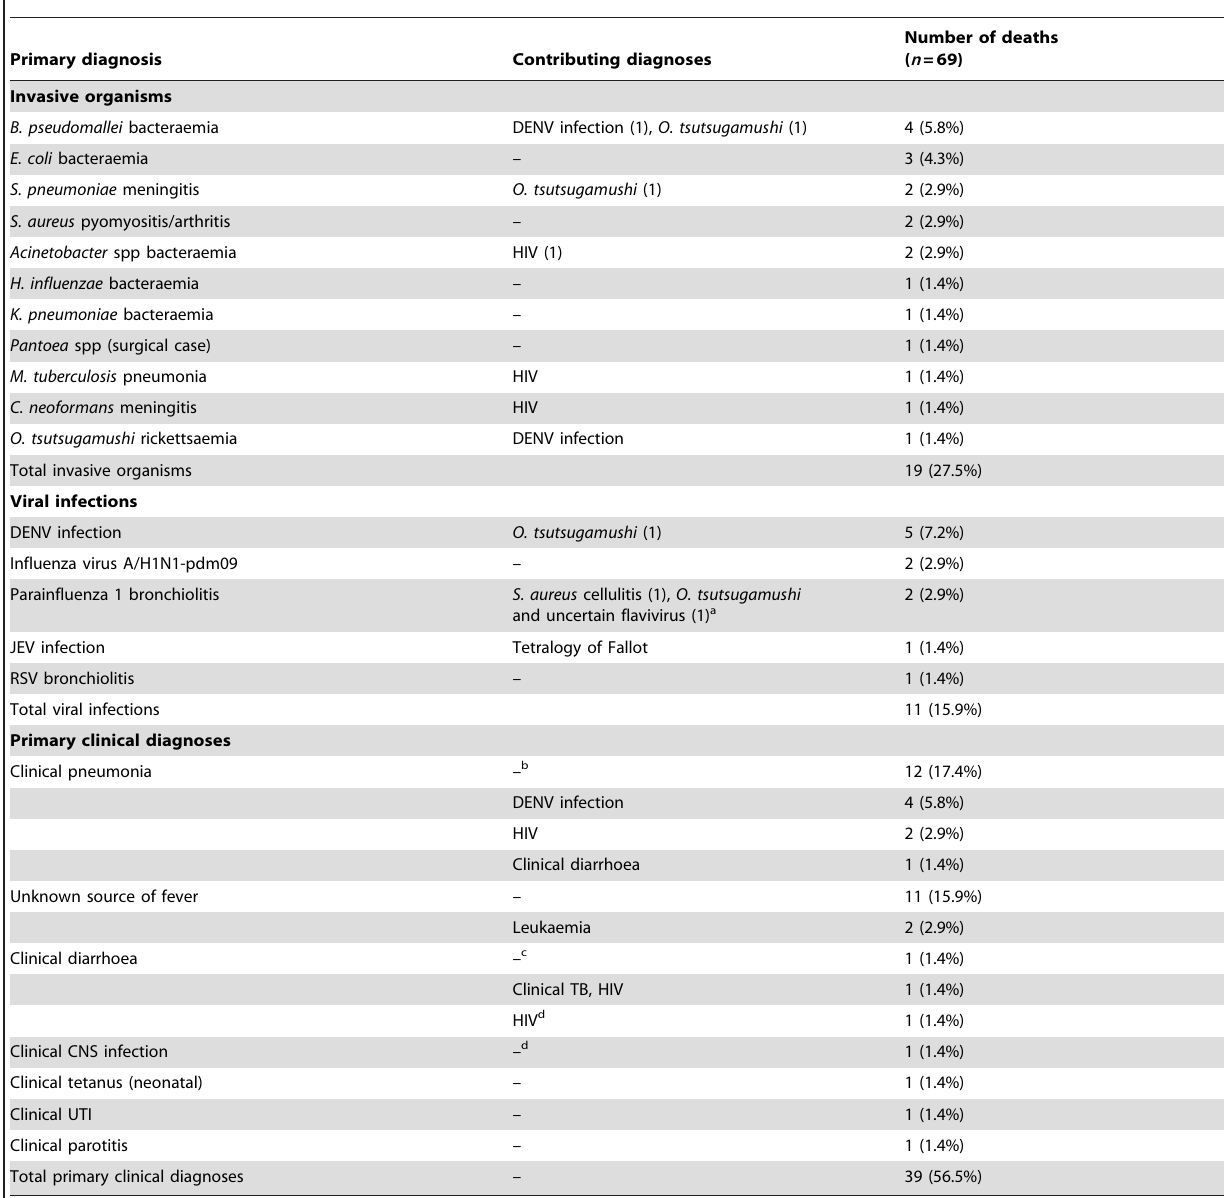
Table 9. Primary diagnosis, and contributing diagnoses, for the 69 children who died during the